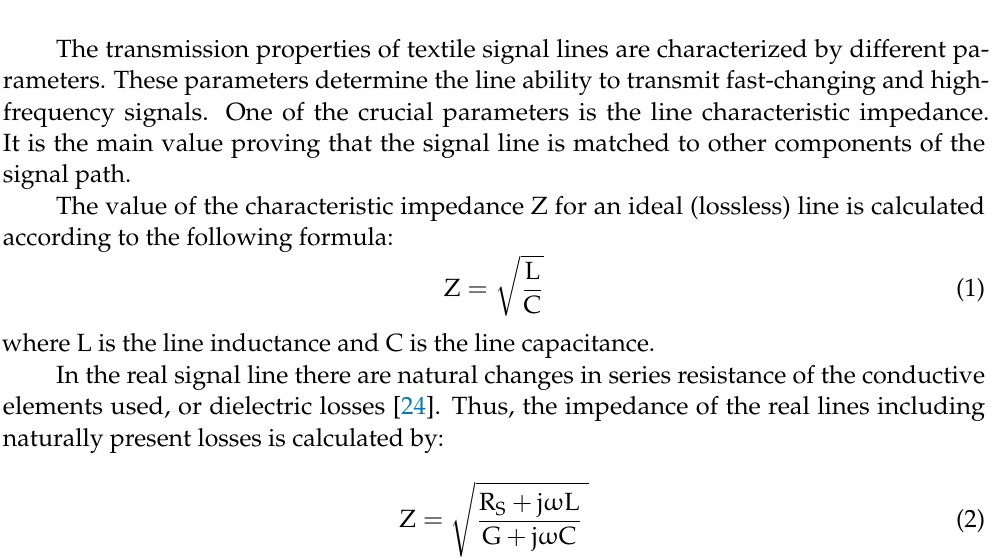
Table 5. TSLs population, divided into groups based on their substrate weave. Weave Number of Lines in the Group Plain 11 Twill 5 Satin